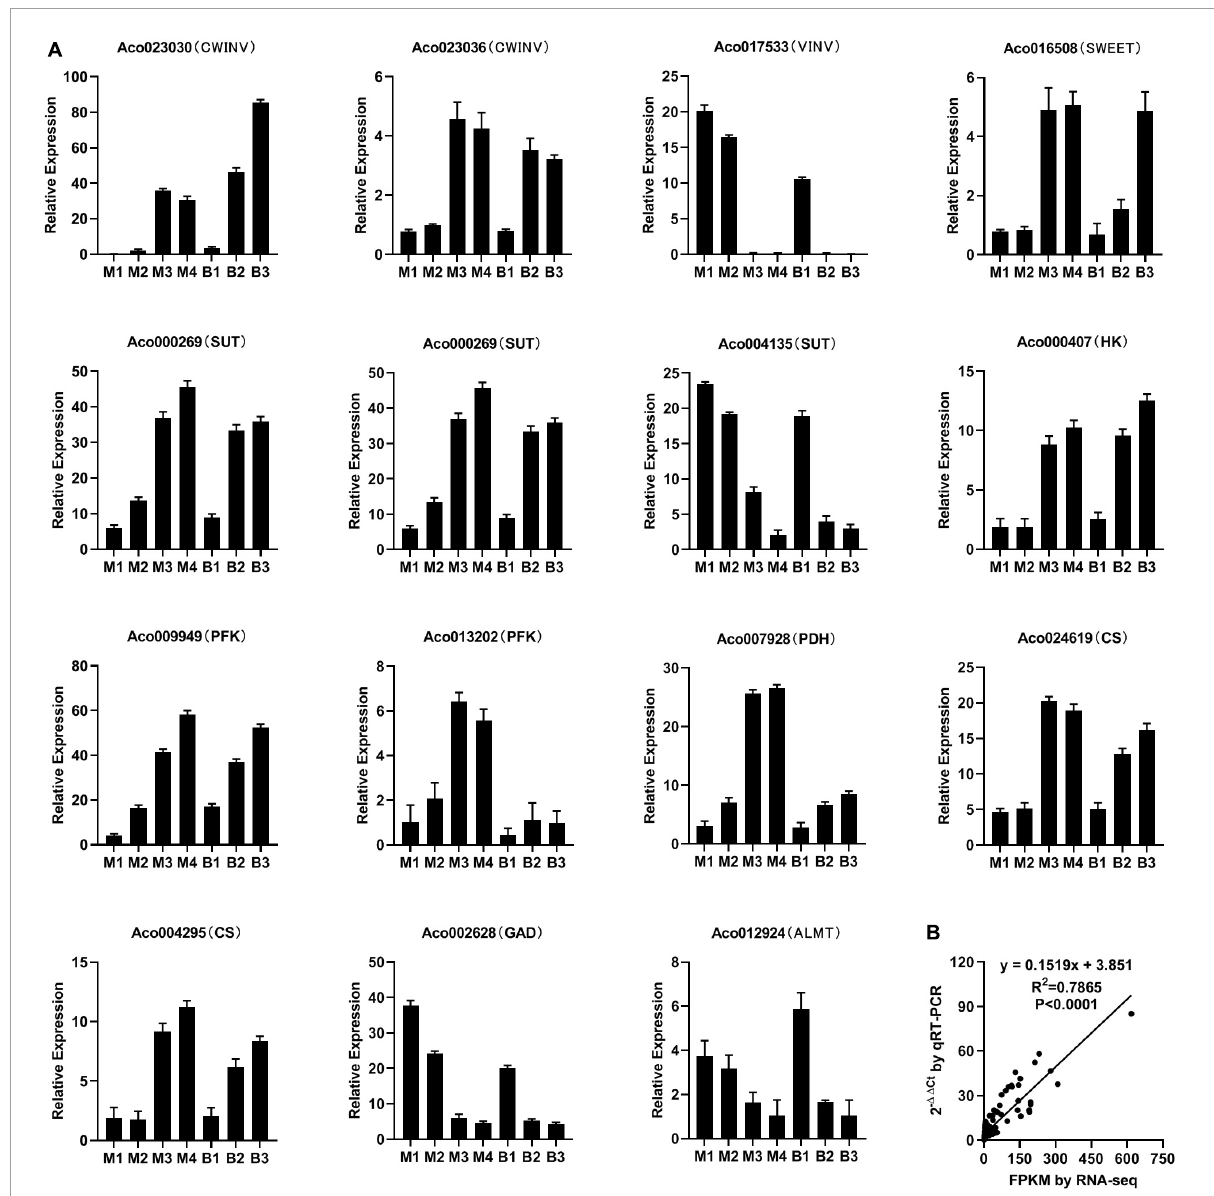
FIGURE6 Relative expression of 15 genes involved in sugar and organic acid metabolism and transport during different developmental stages of M and B by qRT-PCR (A) and correlation analysis between RNA-Seq and qRT-PCR data (B) .